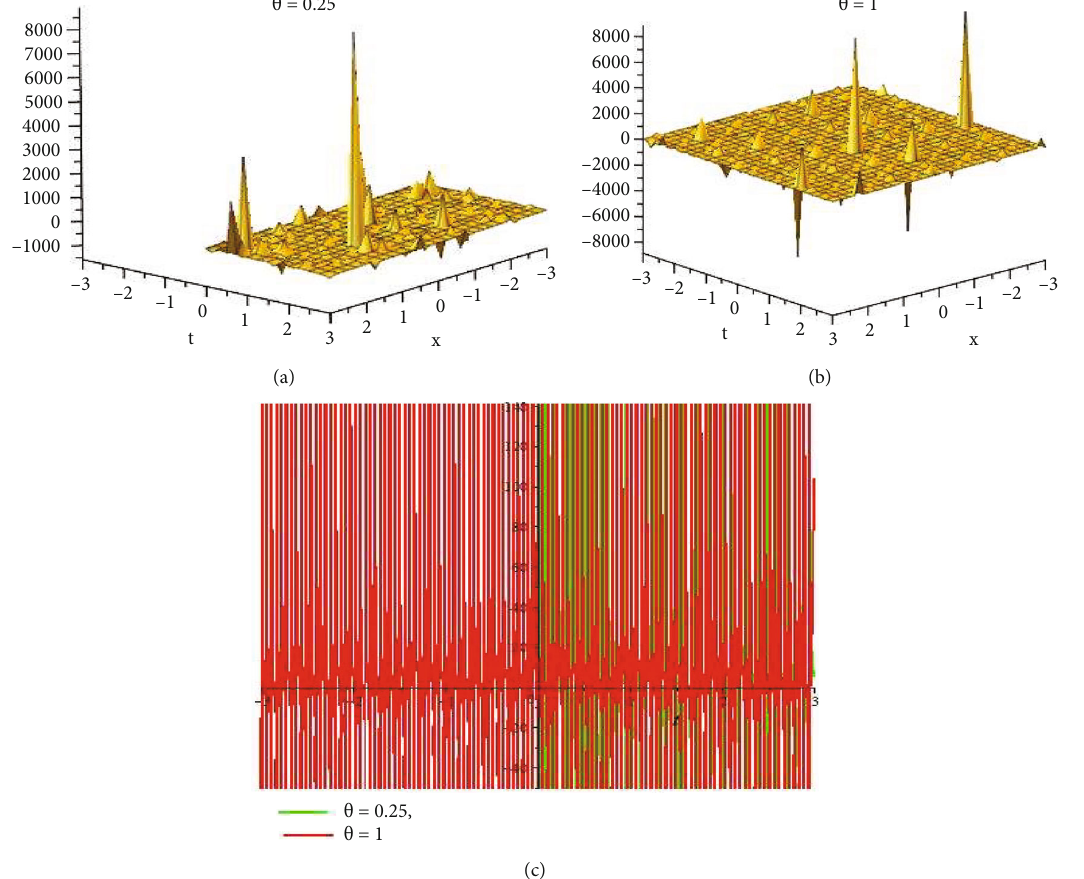
, y , t Þ . (a, b) 3D plot and (c) 2D combined plot for x = 1 4 ð x